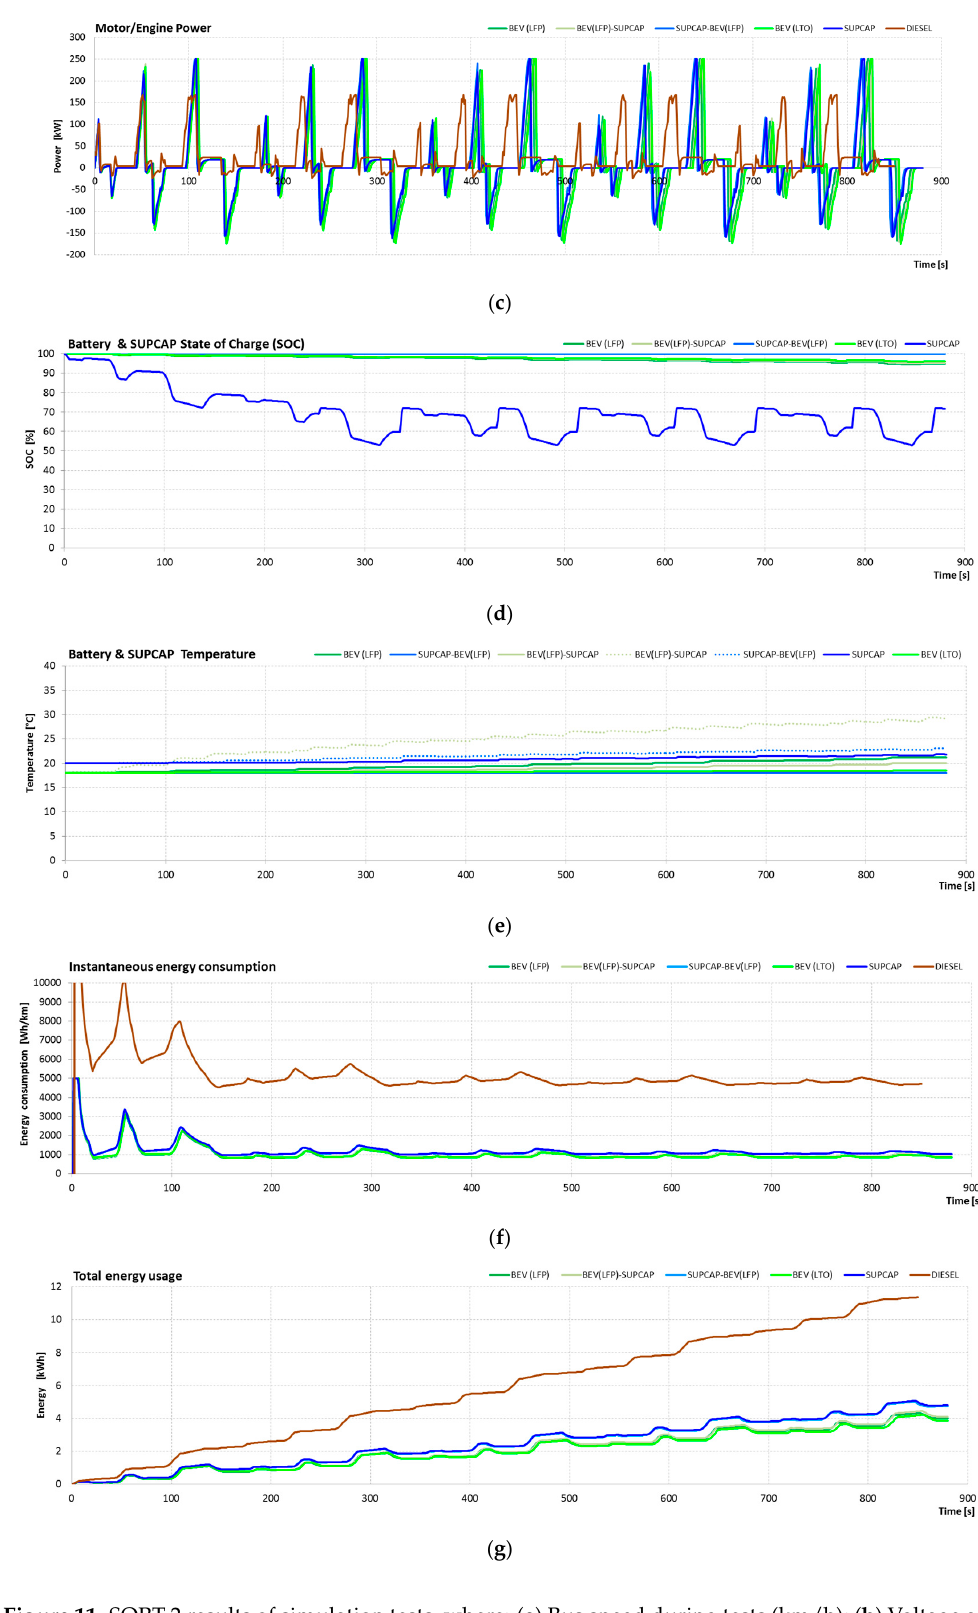
Figure 11. SORT 2 results of simulation tests, where: ( a ) Bus speed during tests (km/h); ( b ) Voltage and Current on DC-link (V), (A); ( c ) Motor/Engine Power (kW); ( d ) Battery & SUPCAP State of Charge (%); ( e ) Battery & SUPCAP temperature (°C); ( f ) Instantaneous energy consumption (Wh/km); ( g ) Total energy usage (kWh).